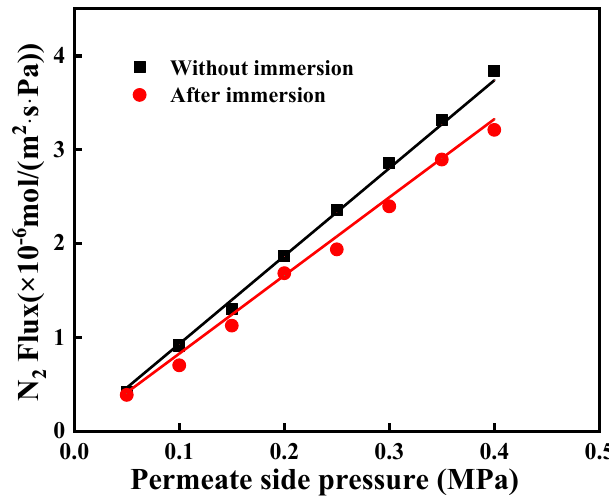
Figure 13. The N 2 flux of the ceramic membrane after 30 day of immersion.